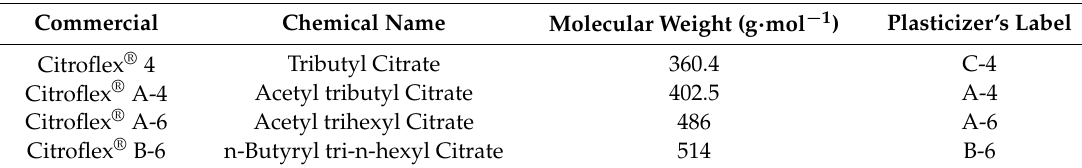
Table 1. Commercial and chemical names of used plasticizers, their molecular weights, and labels.